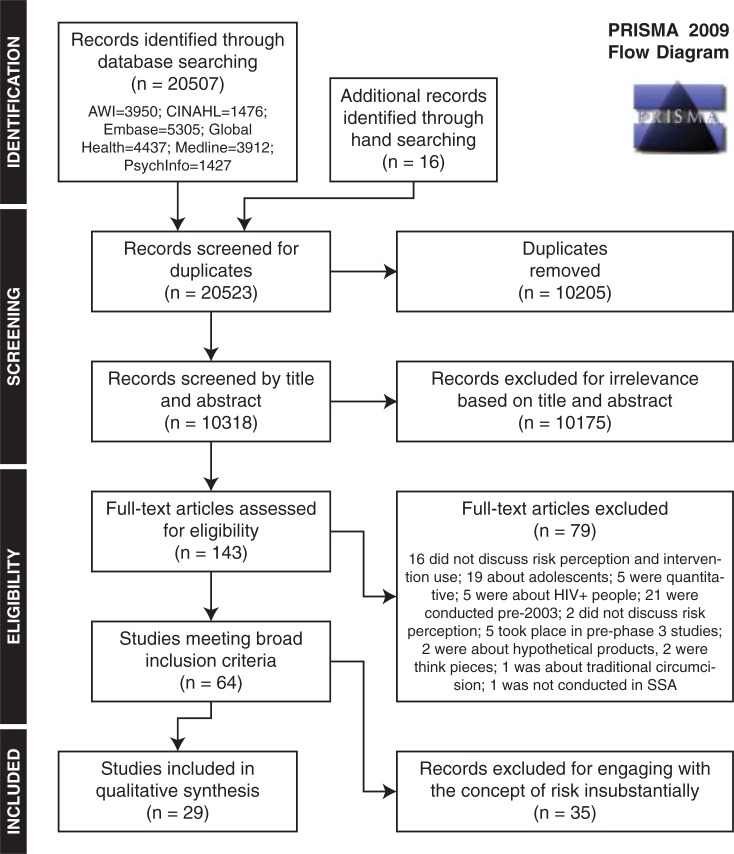
PRISMA flow diagram.